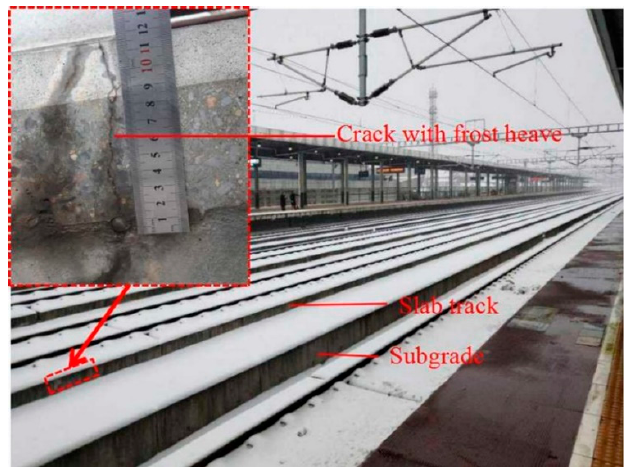
Figure 1. Slab-track cracks with frost heave.